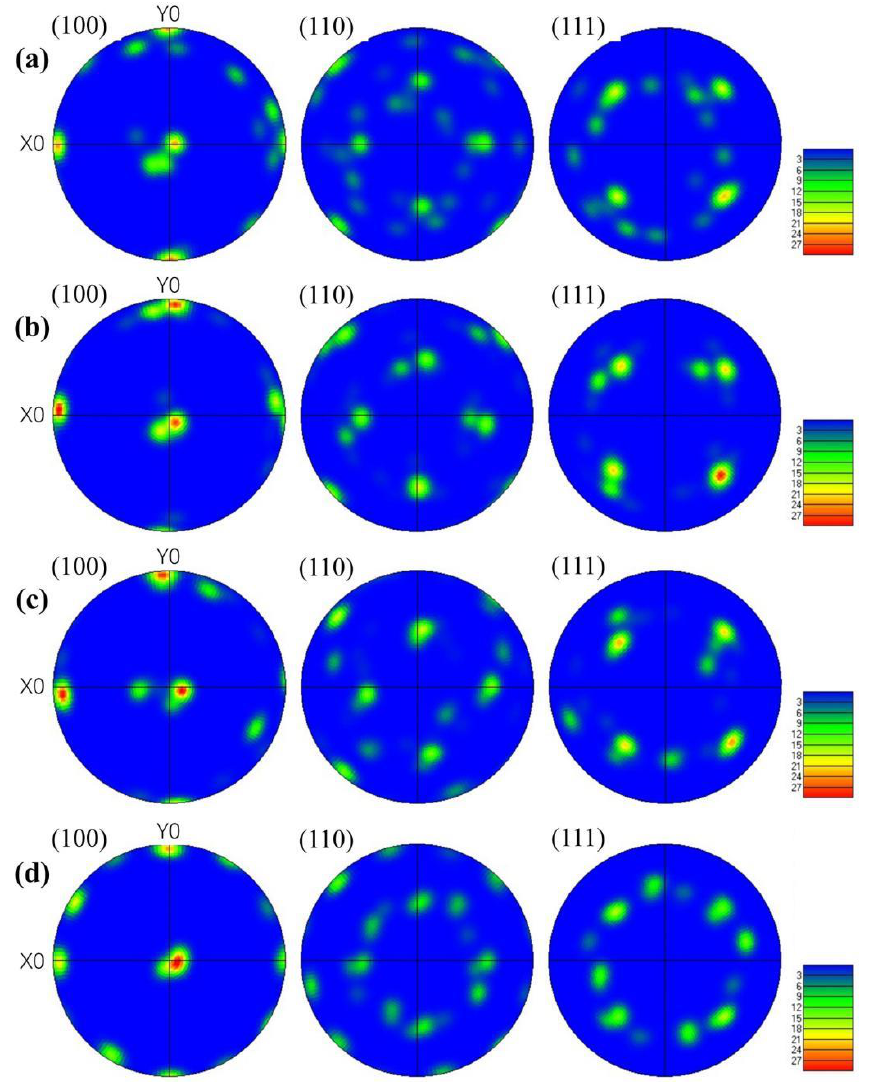
Figure 9. Pole maps of LMD-Al 0.5 FeCoCrNi wall under different heat dissipation rates: ( a ) T-0; ( b ) T-20; ( c ) T-40; ( d ) T-60.